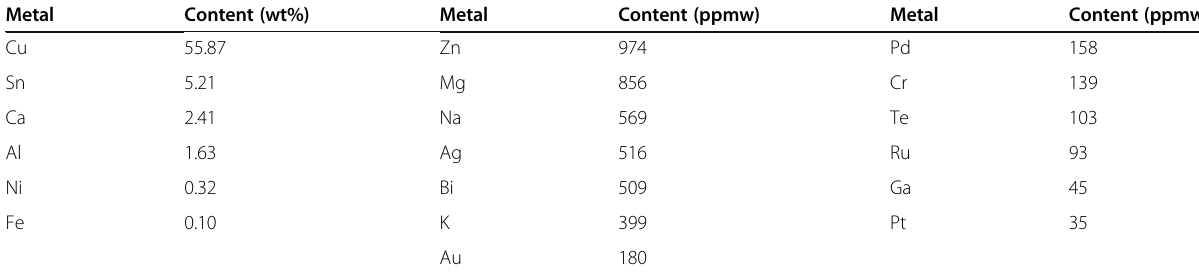
Table 1 Metal composition of waste PCBs